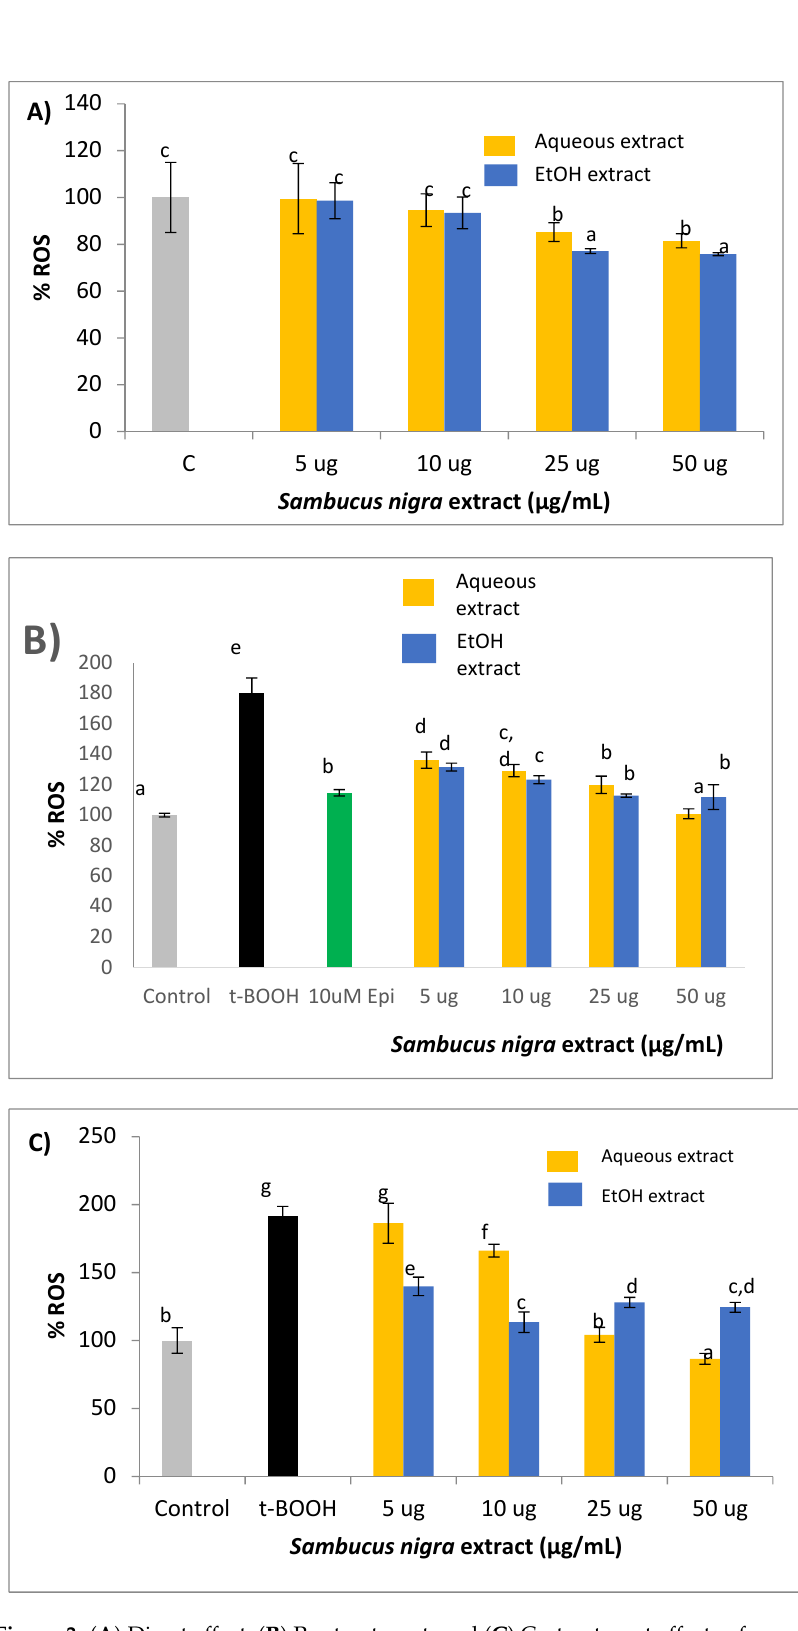
Figure 3. ( A ) Direct effect, ( B ) Pre-treatment, and ( C ) Co-treatment effects of aqueous and ethanolic extracts from S. nigra flowers on ROS generation in SH-SY5Y cells. Values are means ± SD, n = 4. Values are expressed as a percent relative to control condition. Different letters indicate statistically significant differences ( p < 0.05) among groups.